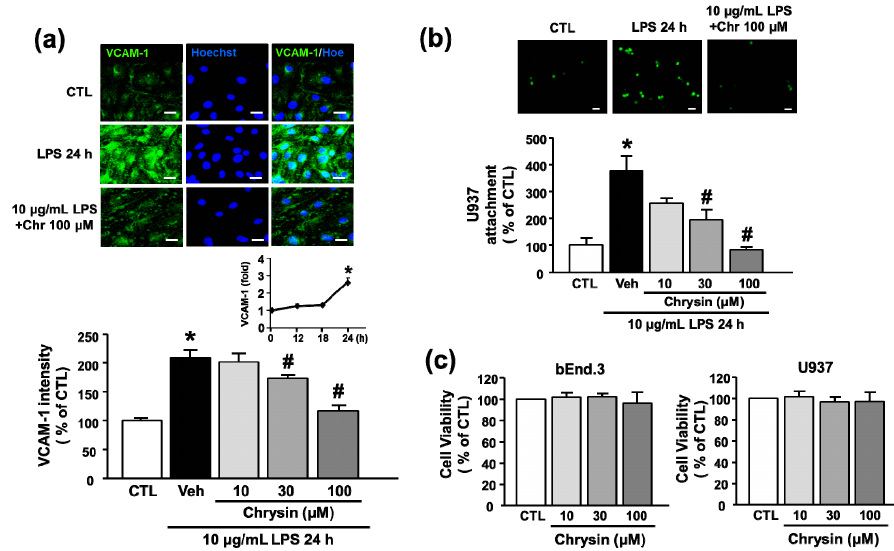
Figure 2. The effect of chrysin on LPS-induced VCAM-1 protein expression and U937 cells attachment to bEnd.3 cells. ( a ) Immunocytochemistry after LPS and chrysin treatment. Inset: bEnd.3 cells were exposed to 10 μ g/mL LPS for the indicated times (0–24 h). Cells were pretreated with chrysin (10–100 μ M) for 30 min and co-stimulated with 10 μ g/mL LPS for 24 h. VCAM-1 (green) was detected by immunofluorescence using anti-VCAM-1 antibody. Nuclei were visualized by Hoechst staining (blue). Representative images and quantitative results are shown in the top and bottom panels, respectively. Scale bar, 20 μ m; ( b ) after treatment with 10 μ g/mL LPS for 24 h in the presence or absence of chrysin, bEnd.3 cells were incubated with U937 monocytes (green) for 2 h. Representative images and quantitative results are shown in the top and bottom panels, respectively. Scale bar: 40 μ m; and ( c ) the effect of chrysin alone on cell viability in bEnd.3 and U937 cells. After the treatment with various concentrations of chrysin for 24 h, the cytotoxicity was determined by MTT assay. Mean ± SEM, * p < 0.05 vs. control and # p < 0.05 vs. vehicle, n = 3.